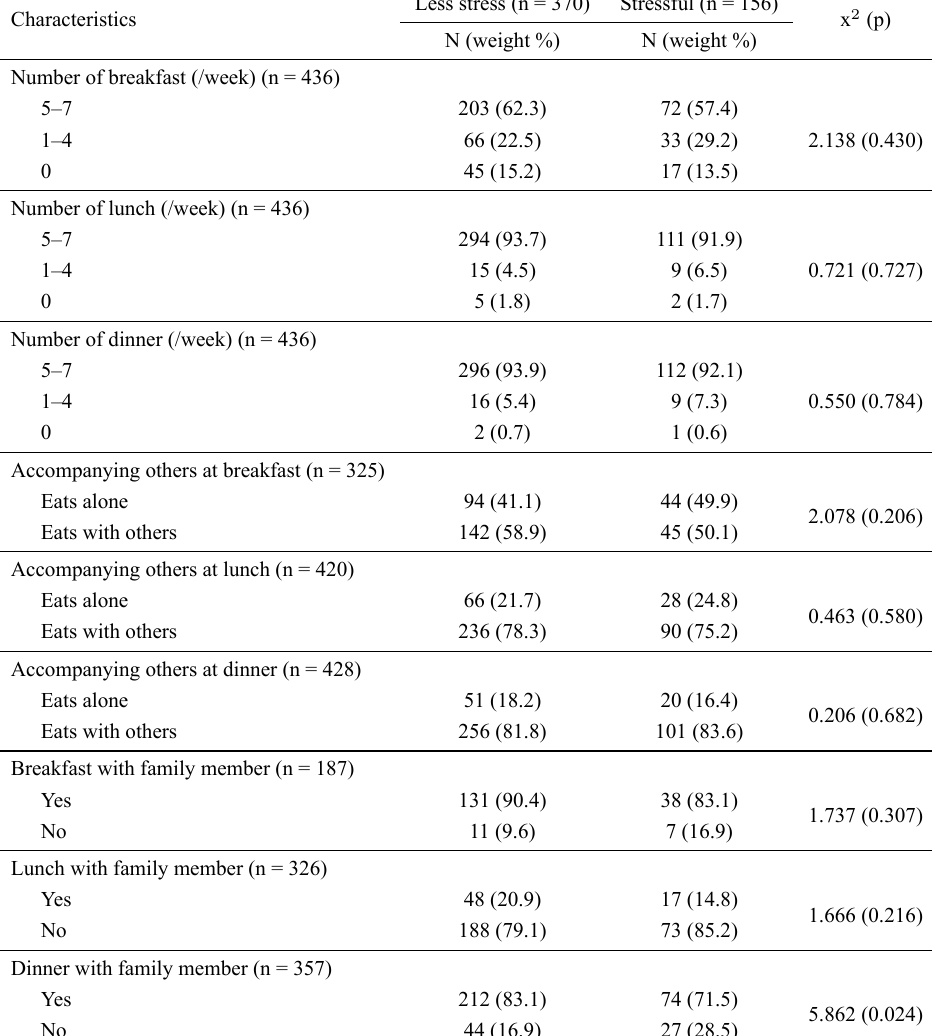
Table 3. Comparison of dietary behavior characteristics according to stress level (n = 526).